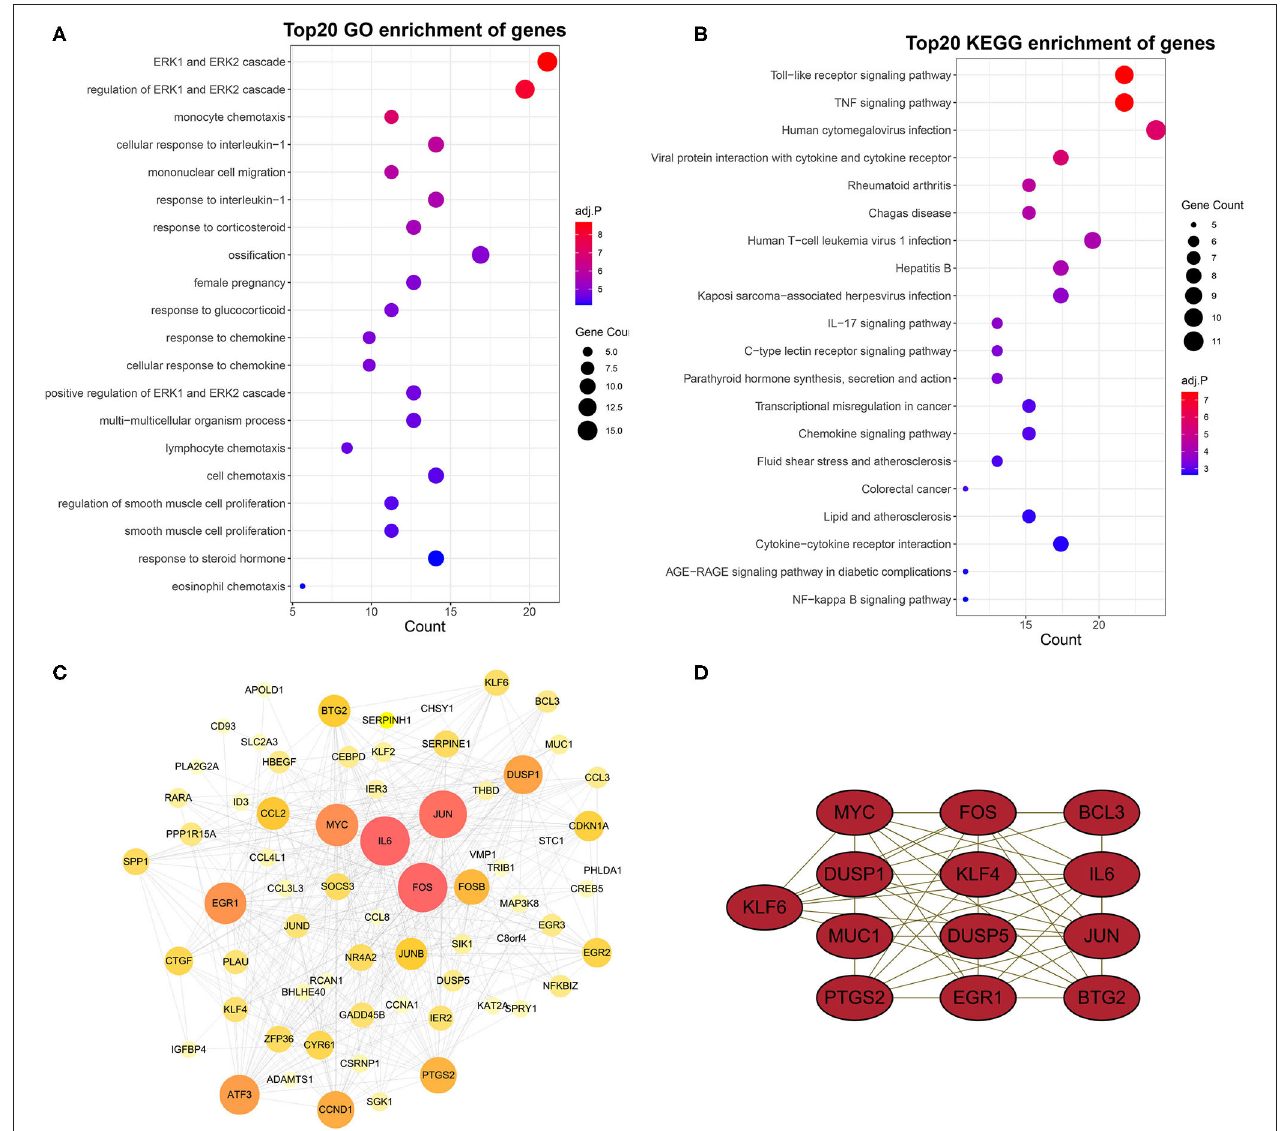
FIGURE 4 | GO and KEGG enrichment analysis and PPI network and hub genes. GO (A) and KEGG (B) enrichment analysis of yellow module genes. (C) PPI network analysis of yellow module genes. Edge indicates that there is an interaction between two proteins. The greater the node indicates that the protein is more important in the network. (D) Most closely connected network cluster in the PPI network was identified using the MECOD plugin (score = 8.667, nodes = 13, edges =